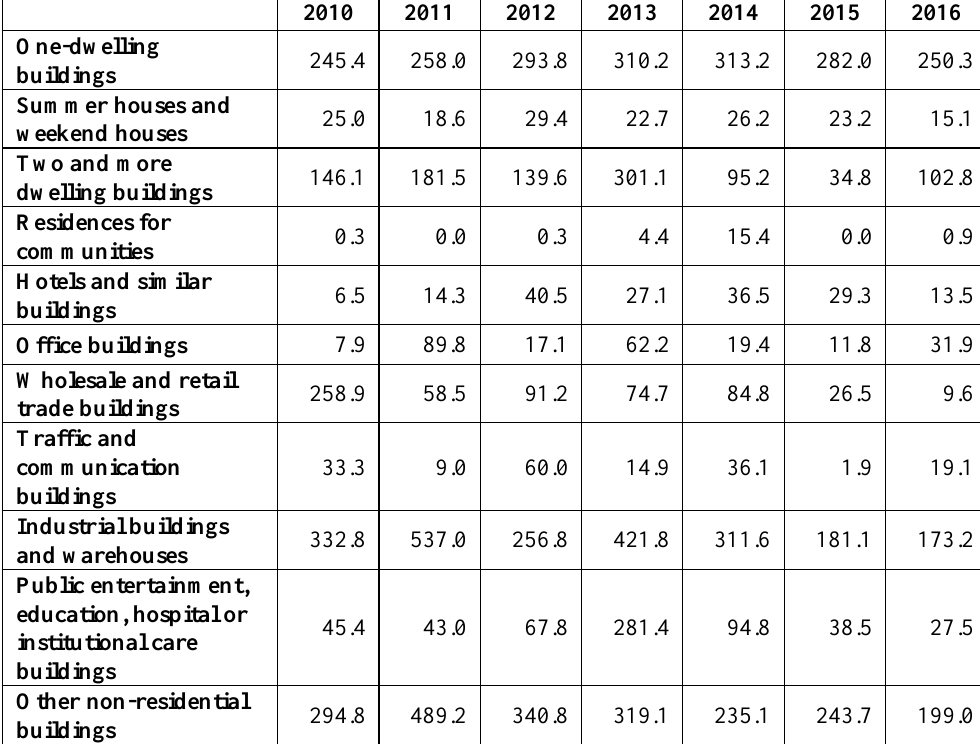
Table 4. Number of building permits granted and the expected floor space in statistical regions and cities under state jurisdiction. Data: Central